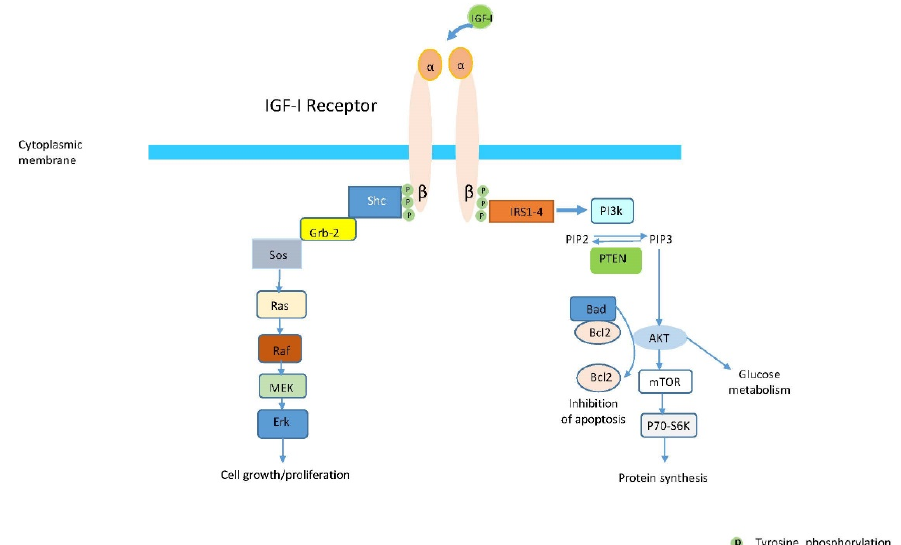
Figure 1. Binding of IGF-I to the extra-cellular alpha subunit induces a conformational change of the IGF-IR, which enables autophosphorylation of the intrinsic tyrosine kinases domains of the beta subunits of the IGF-IR. In the classical model of signaling, this was considered the first step in the intracellular signaling cascade of post-receptor events. This further results in downstream stimulation of either phosphatidylinositol 3 kinase (PI3K/AKT) and mTOR or MEK (ERK1 and ERK2) proteins leading the activation of different genes and the initiation of different cellular processes. This involves the participation of many cytoplasmic proteins such as IRS-1, PI3K, PTEN. AKT, mTOR, and SK6 in one signaling branch and Shc, Grb2, Sos, Ras, Raf, MEK and ERK in a second signaling branch.